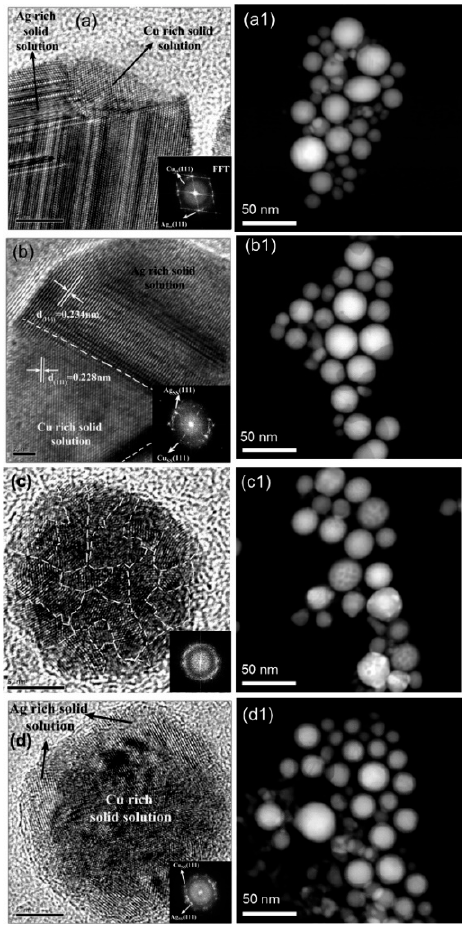
Figure 12. HRTEM photomicrographs of AgCu nanoalloys, showing four different microstruc- tures: ( a , b ) separated phases, ( c ) nanograins and ( d ) core-shell with, respectively, four different Cu concentrations (20%, 40%, 60%, 80%). ( a1 – d1 ) images of four respective target compositions at low magnification. Reproduced with permission from Reference [237]. Copyright 2014, American Chemical Society.